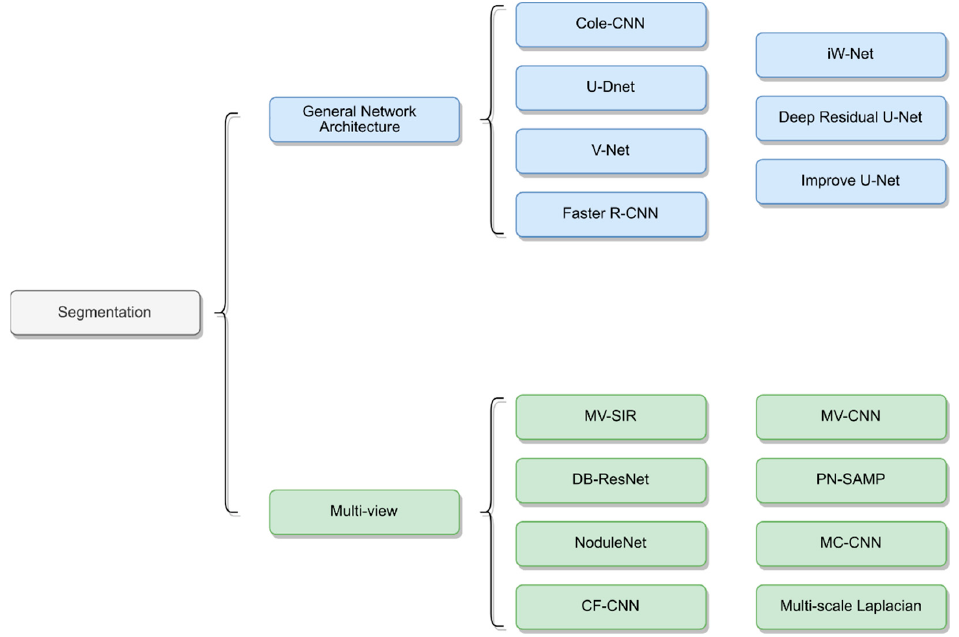
Figure 2. Network architecture of lung nodule segmentation.